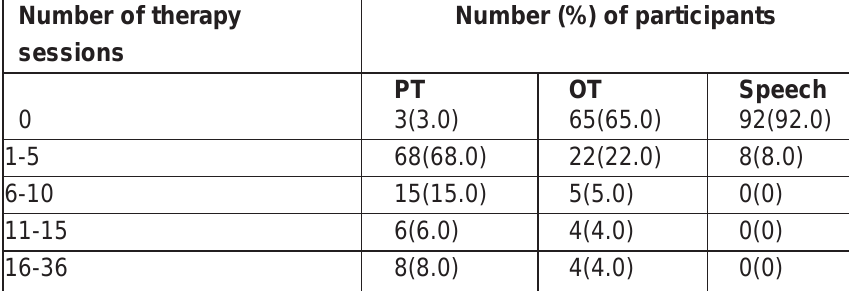
Table 4: Number of physiotherapy, occupational therapy and speech therapy sessions the participants received between baseline and six months post stroke